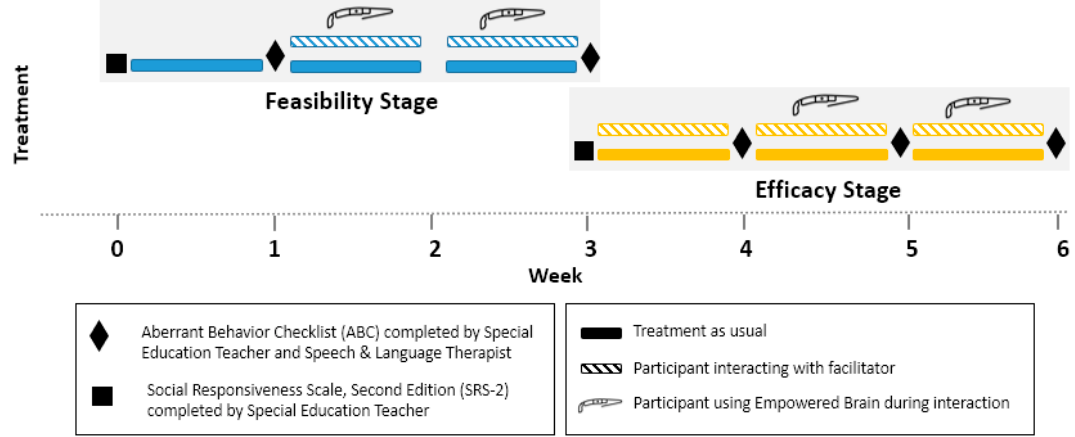
Figure 2. Outline of experimental study methodology across both feasibility and efficacy stages.